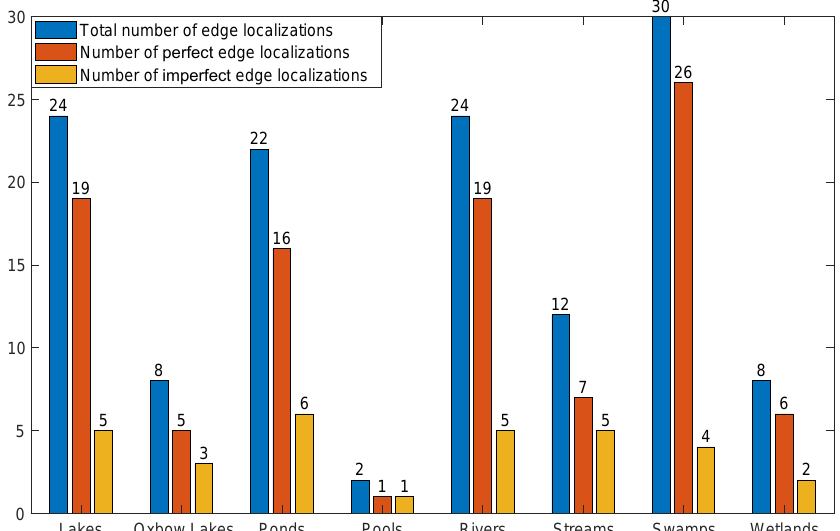
Figure 16. Statistics of water body edge localization by the proposed radar technique per water body